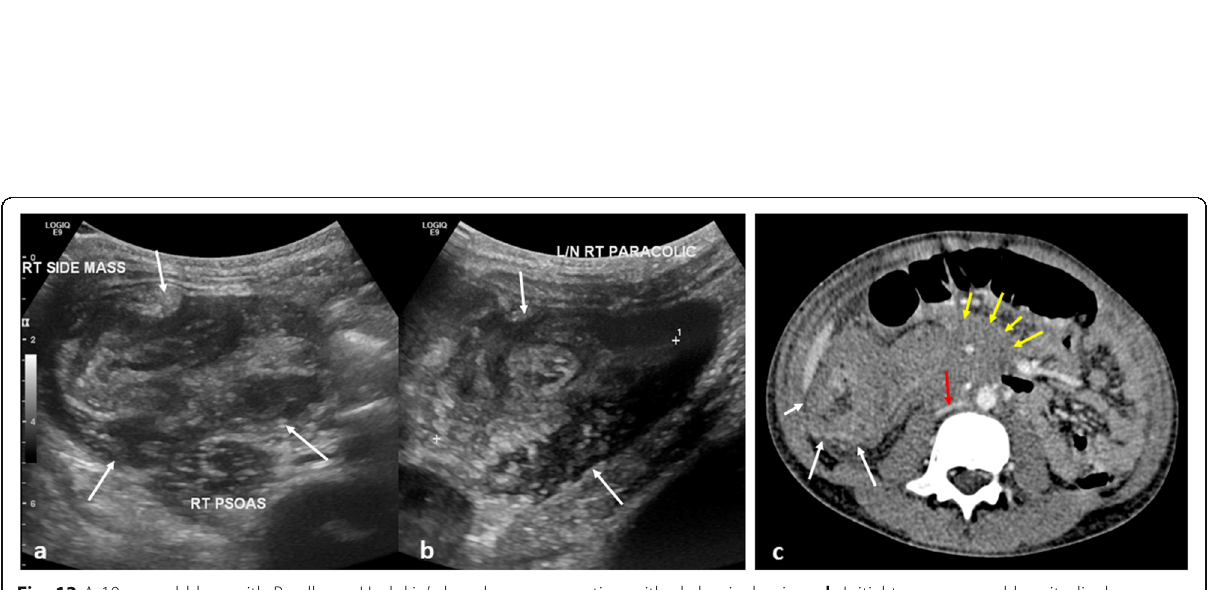
Fig. 13 A 10-year-old boy with B-cell non-Hodgkin ’ s lymphoma, presenting with abdominal pain. a , b Initial transverse and longitudinal ultrasound views of the right paracolic gutter demonstrated a large complex mass (white arrows), suspected to represent an intussusception. c Axial contrast-enhanced CT of the abdomen, confirmed the finding of the intussusception (white arrow) with adjacent areas of inflamed and matted bowel loops, likely to represent an infiltrative process such as lymphoma. Further areas of extensive lymphadenopathy, predominantly in the pelvis and around the mesenteric vessels (yellow arrows) with compression of the IVC (red arrow), were also noted as ileo-colic intussusception. Given the age, size of the patient and subacute clinical history, air-reduction enema was deemed inappropriate and the patient underwent a surgical reduction of the